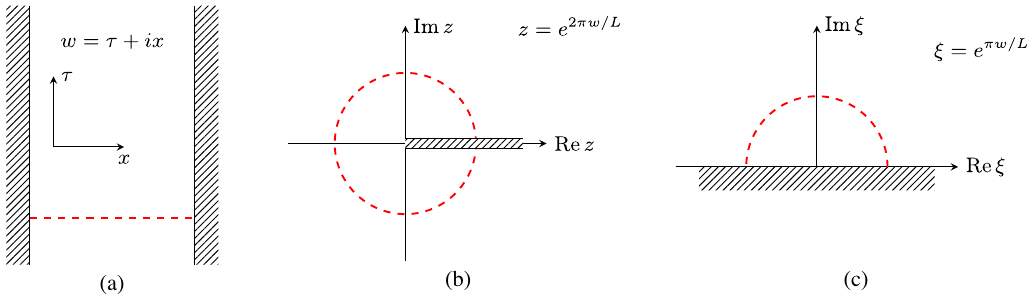
FIG. 1. Schematic plot of the three geometries. (a) Strip geometry where the ð 1 þ 1 Þ D CFT with an open boundary is defined. (b) z plane where we compute the operator evolution. (c) ξ plane where we compute the operator expectation values.